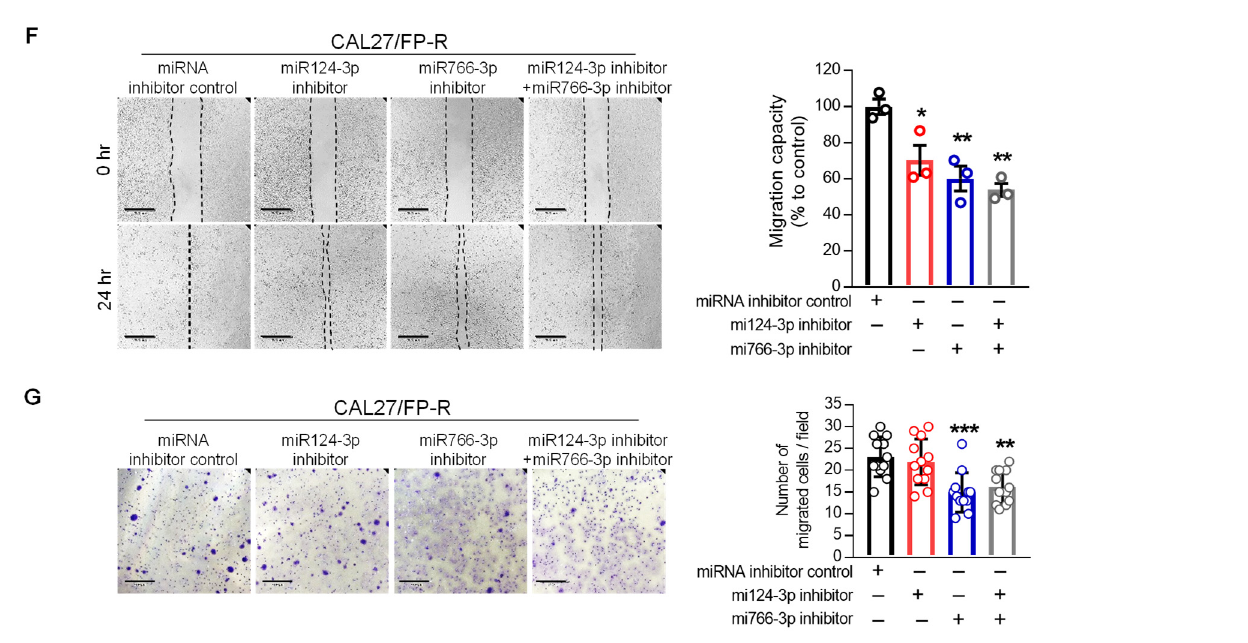
Figure 5. The upregulation of miR124-3p and miR766-3p is associated with acquired resistance in HNSCC cells. ( A ) Dose–response curves of the resistant CAL27/FP-R cell line towards cisplatin and 5-FU. Cell viability was assessed using MTT assay. ( B ) The effect of cisplatin and 5-FU on cell survival in CAL27 and CAL27/FP-R cells. Cell survival was assessed using an MTT assay on Days 1, 3, and 5 after treatment with cisplatin and 5-FU combination. ( C ) Determination of cell migration by Transwell chamber-migration assay in CAL27/FP-R cells, as described in Figure 4. ( D ) Relative level of miR124-3p and miR766-3p in the CAL27/FP-R cell line, measured by qRT- PCR. ( E ) The effect of miRNA inhibition on drug-induced cytotoxicity in the resistant cell line (CAL27/FP-R). Cells were transfected by 10 nM inhibitor (single or combined) for 24 h followed by 72 h exposure to the indicated drug. Cytotoxicity was determined by MTT assay. * p < 0.05 (vs. miRNA inhibitor control). ( F ) Measurement of cell migration by scratch wound healing assay following 24 h treatment with 10 nM miRNA inhibitor (single or combined). ( G ) Measurement of cell migration by Transwell chamber-migration assay following 24 h treatment with 10 nM miRNA inhibitor (single or combined). Each dot represents 1 field × 4 images per transwell × triplicate = total 12 fields per treatment condition. These assays are described in Figure 4. A one-way ANOVA with Bonferroni’s correction for multiple comparisons was used to analyze group comparisons, and data are presented as means ± SD (n = 3). * p < 0.05, ** p < 0.01 and *** p <